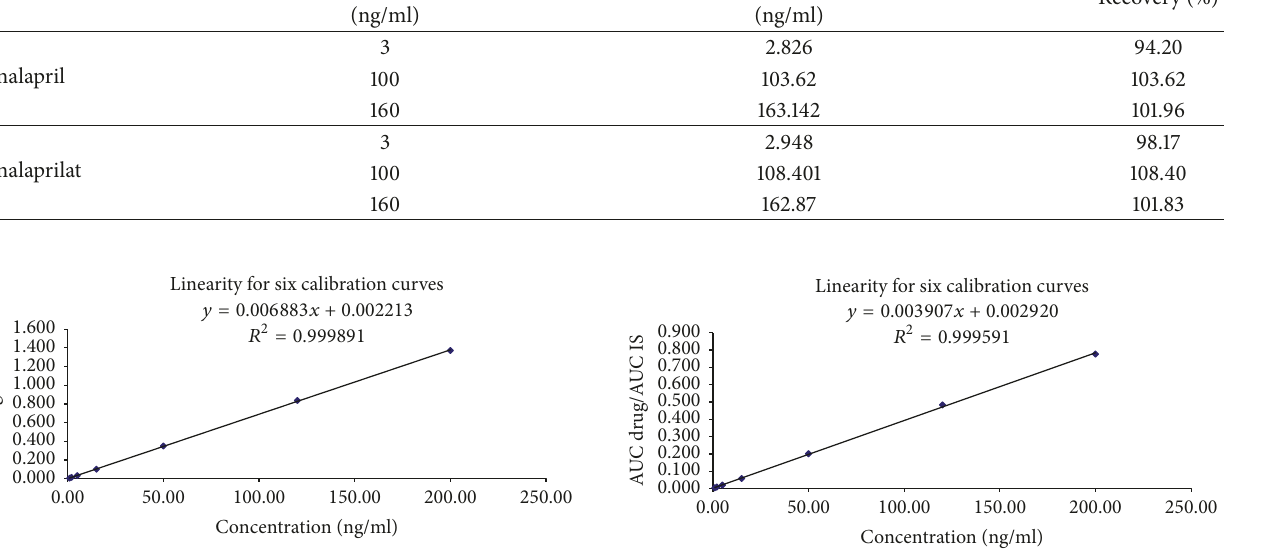
Table 3: Absolute recovery of enalapril and enalaprilat from plasma ( 𝑛 = 6 ). Spiked concentration Mean concentration